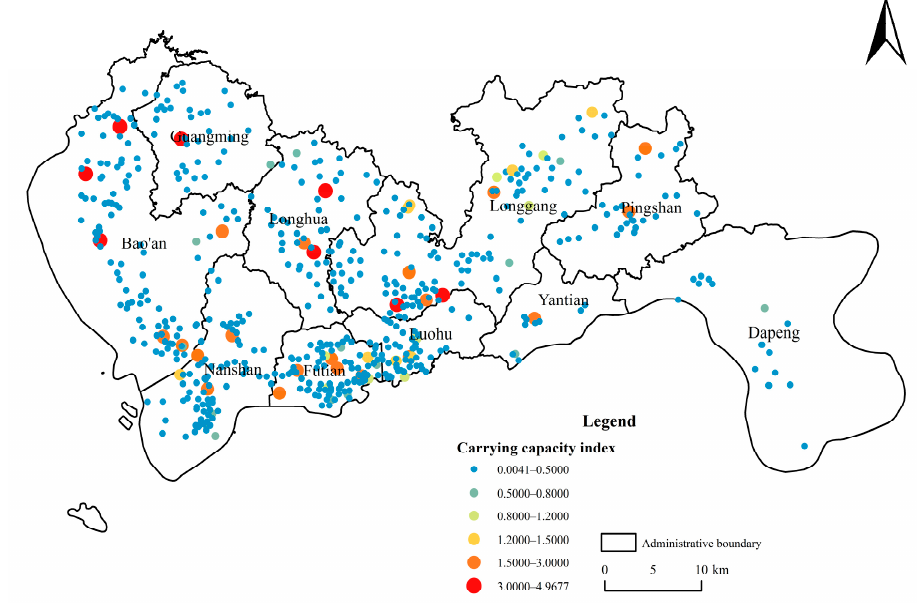
Figure 7. Evaluation results for the carrying capacity of public medical services in Shenzhen.